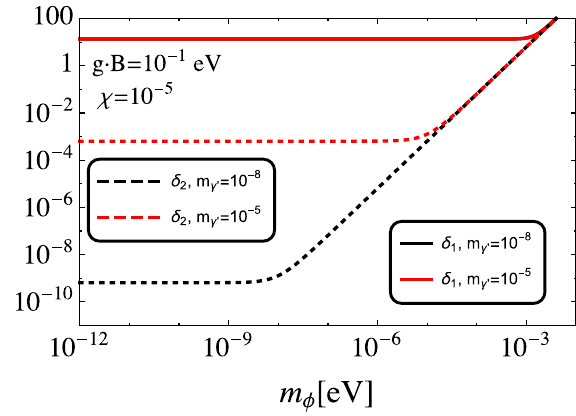
angle δ 2 isclearlydominatedby thehighermass(between m φ and m γ (cid:4) ), so for small masses we can have δ 1 (cid:2) δ 2 (this is the strong regime). As one of the masses gets bigger (always in comparison to gB ), the oscillation angles become basically equal. This ’catching up’ of δ 2 to δ 1 is highly dependent of the strength of